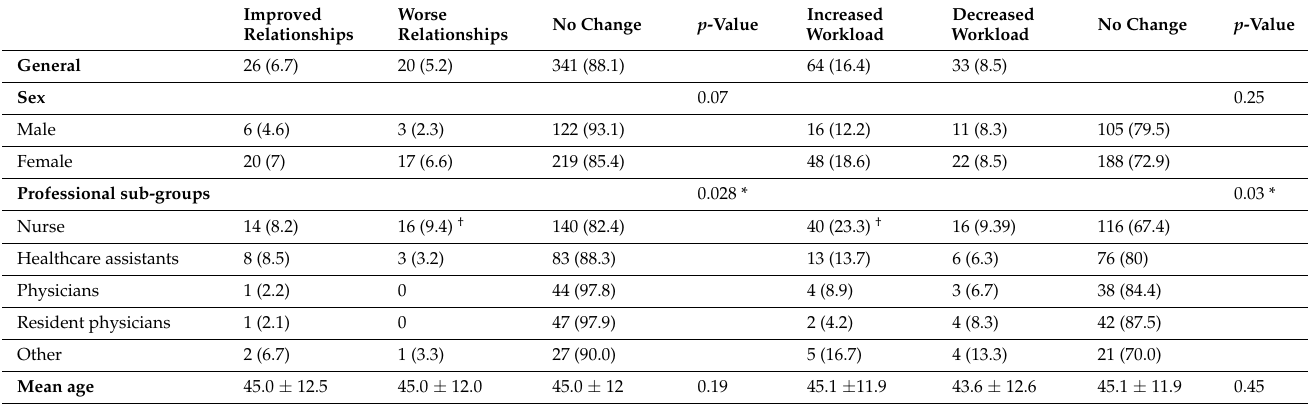
Table 4. At-work relationships and workload 3 months after the infection according to sex, profes- sional sub-groups, and